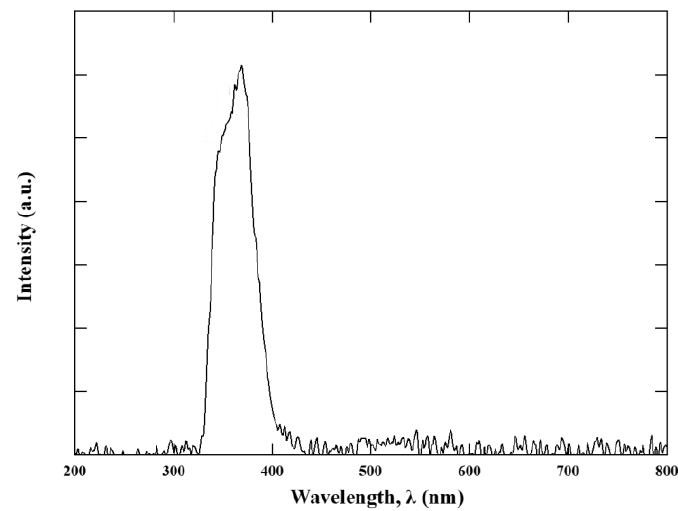
Figure 5. RL spectra of the eutectic sample under X-ray irradiation.